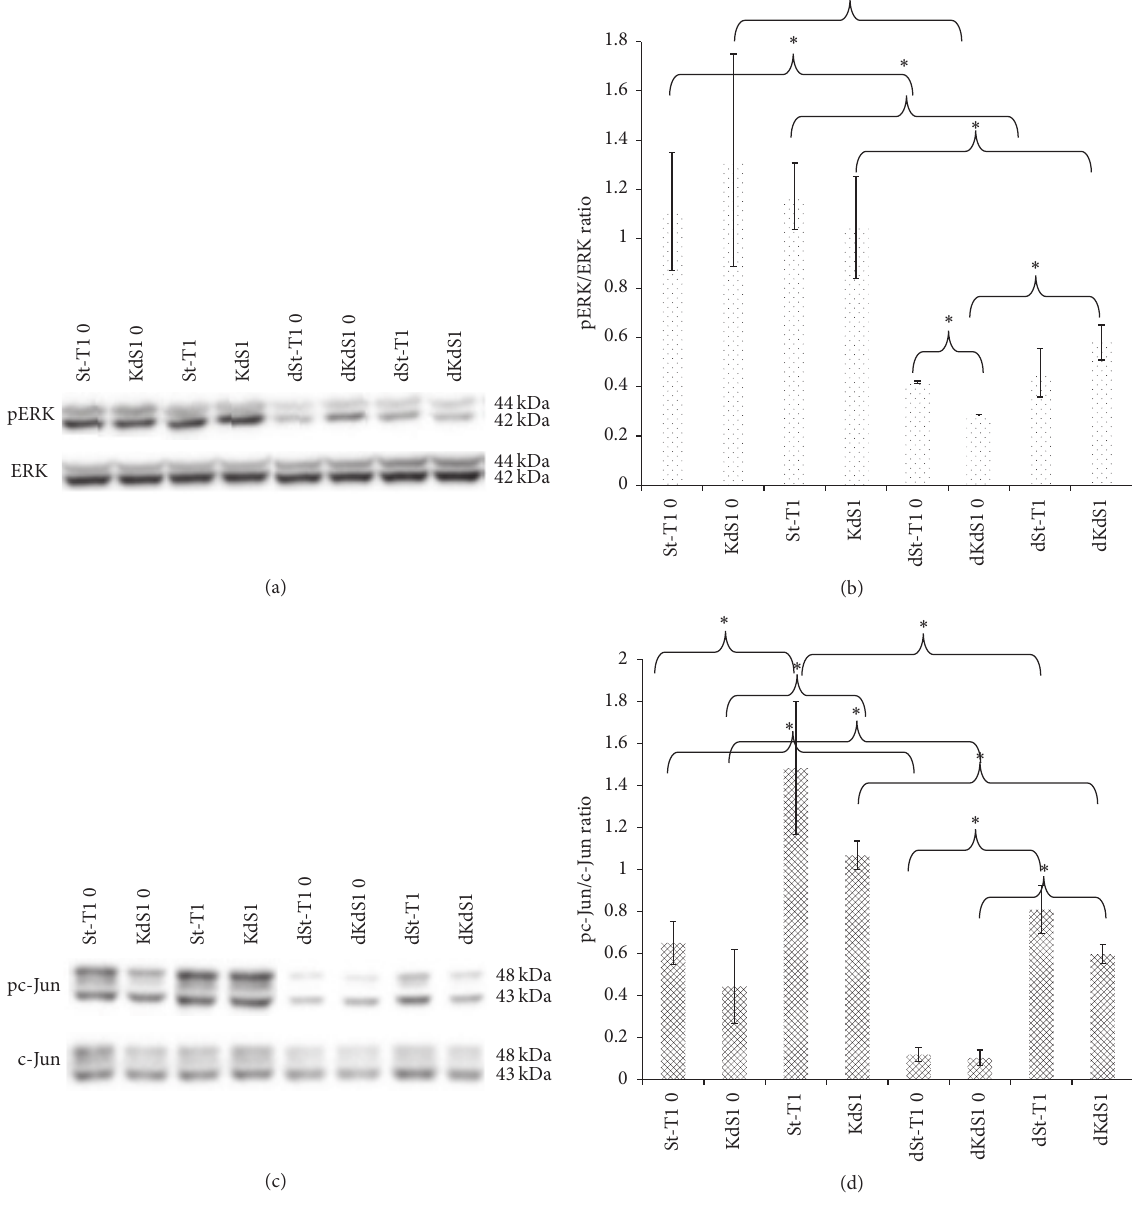
Figure 3: Protein expression analysis of ERK/pERK (44, 42 kDa) and c-Jun/pc-Jun (48, 43 kDa), in St-T1 and the Sdc-1 kd cell line KdS1 (+/ − d). (a) shows the protein expression of ERK and pERK in St-T1, dSt-T1, KdS1, and dKdS1 after treatment with IL-1 𝛽 for 15min compared to controls without IL-1 𝛽 treatment in a representative western blot, in (b) the corresponding pixel density evaluation as pERK/ERK ratio, in (c) the c-Jun and pc-Jun expression in St-T1, dSt-T1, KdS1, and dKdS1 after treatment with IL-1 𝛽 for 15 min compared to controls without IL-1 𝛽 treatment in a representative western blot, and in (d) the corresponding pixel density evaluation as pc-Jun/c-Jun ratio. Data represents means ± SD with ∗ 𝑝 < 0.05 . GAPDH served as control (data not